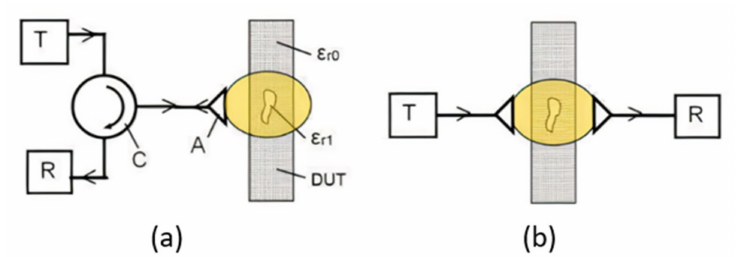
Figure 6. Microwave testing in ( a ) reflection mode and ( b ) transmission mode